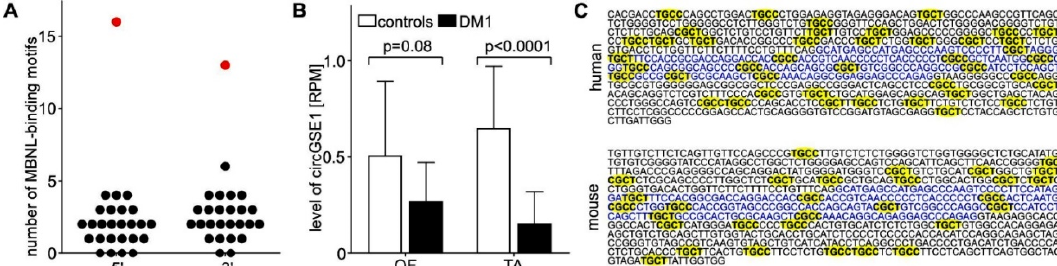
Figure 4. CircGSE1 as an example of MBNL-regulated RNA. ( A ) Dot plot depicting a number of potential MBNL-binding sites in introns flanking circGSE1 (red dots) and 25 randomly selected circRNAs (black dots). The regions of flanking introns embracing 300 nt upstream and 300 nt downstream from circRNA-generating exons were used to determine a number of MBNL-binding sites. ( B ) The level of circGSE1 (expressed as read per million, RPM) is decreased in two types of skeletal muscles QF and TA from DM1 patients. ( C ) Localization of potential MBNL-binding sites (highlighted in yellow) in circGSE1 exon (blue font) and in 300-nt fragments of its flanking introns (black font) is shown in both human and mouse ortholog.